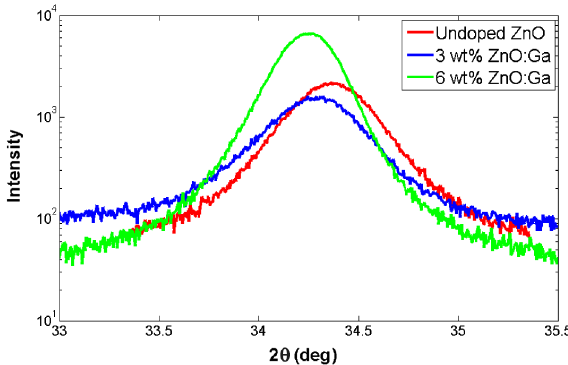
FIG. 4 (color online). X-ray diffraction ( ω − 2 θ ) patterns for ZnO, 3 wt% GZO, and 6 wt% GZO thin films. The peak shown in the figure corresponds to 002 reflection.